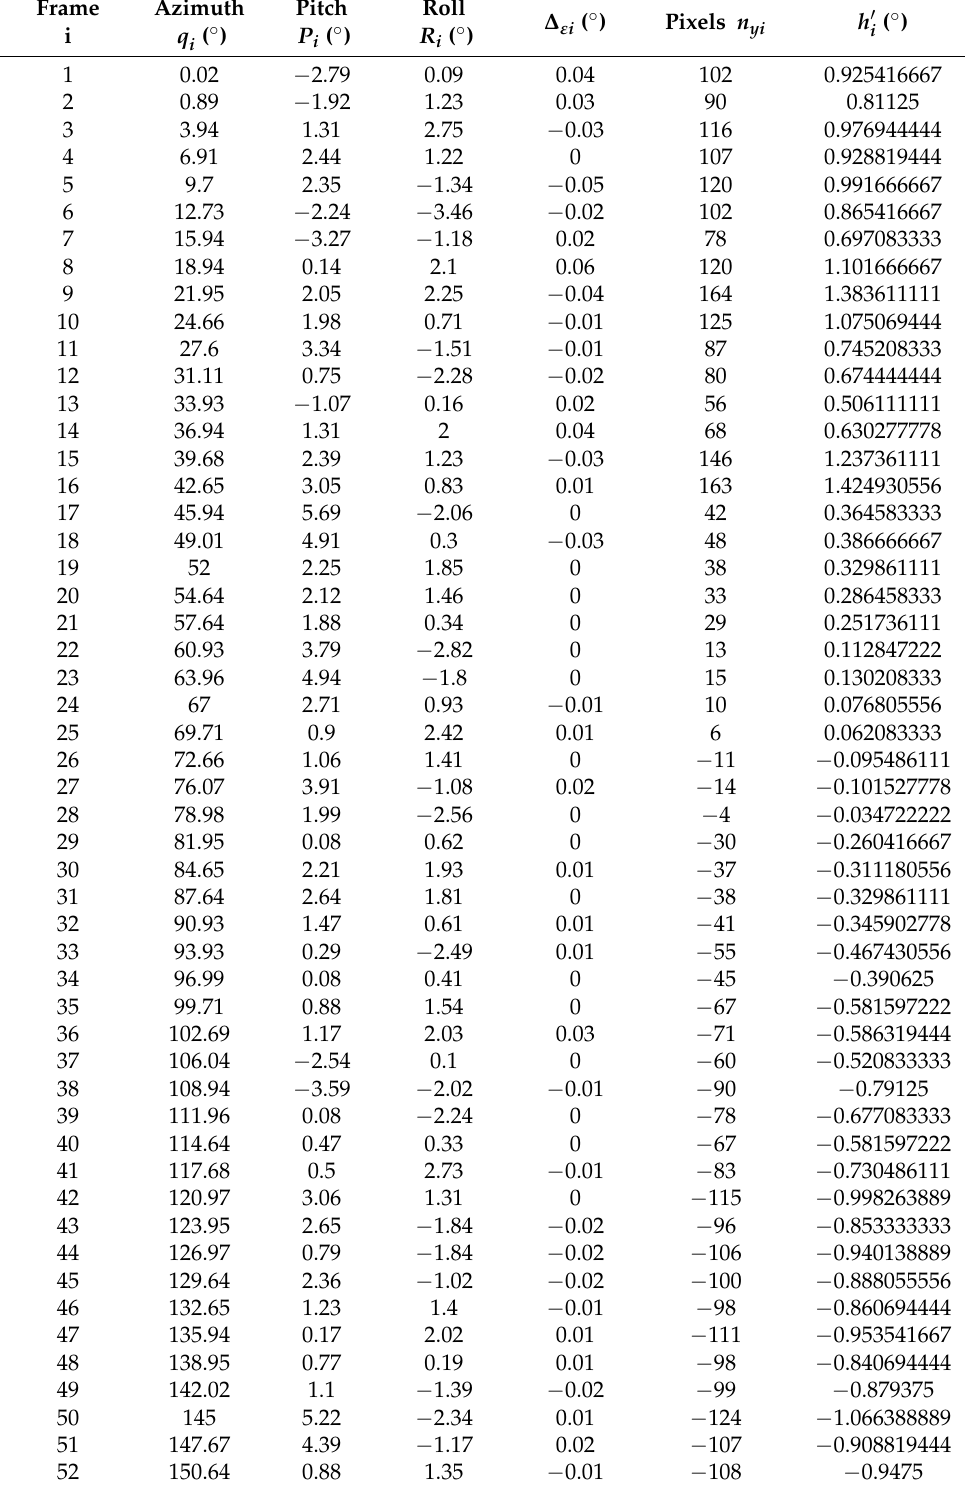
Table 1. The 120 groups of data collected in the